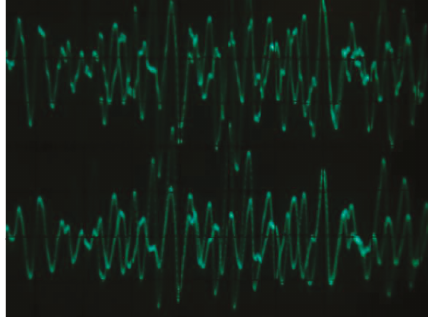
Figure 22: The transmitting modulation signal and the receiving demodulation signal photo.